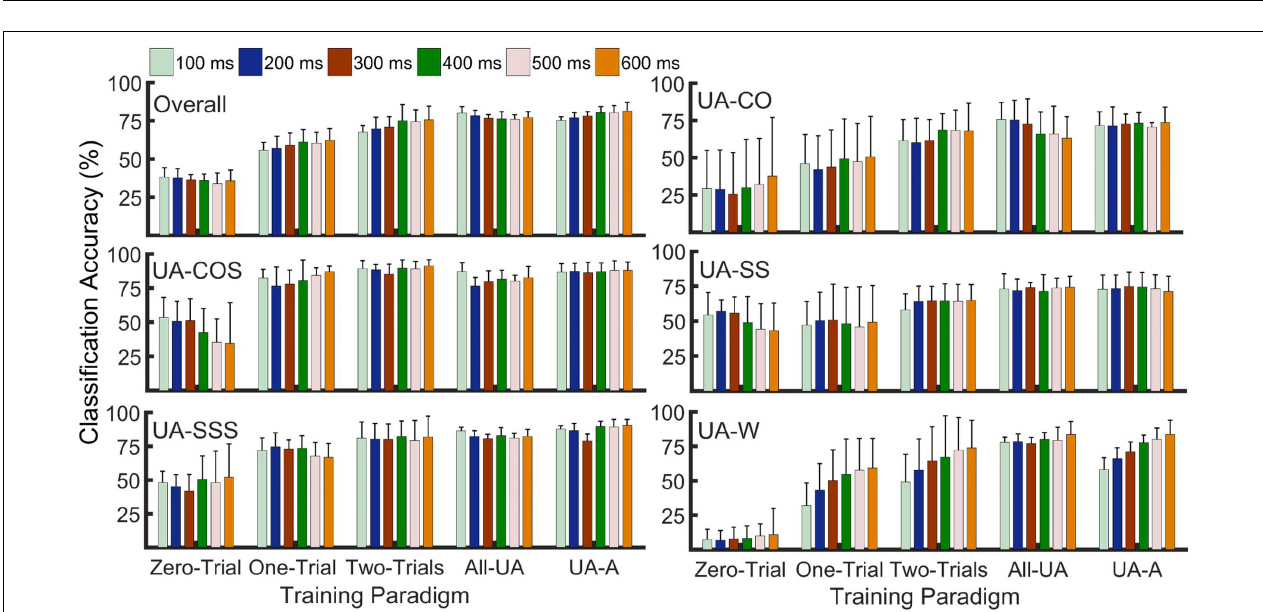
FIGURE 3 | Classification error versus time for anticipated straight walking (A-W), cuts (A-CO, A-SS), and cuts to stair ascent (A-COS, A-SSS). The graphs demonstrate the possibility of predicting the tasks with error rates of < 20% as early as 200 ms prior to entering the transition (TTO1). Each trial was initiated by the first trailing leg heel strike (THS1). To execute cut, subjects started the transition at the first trailing leg toe off (TTO1) and ended with the second trailing leg heel strike (THS2). LTO2 stands for the second leading leg toe off. Gait events are the average across subjects. X -axis data was shown up to the length of the shortest trial.